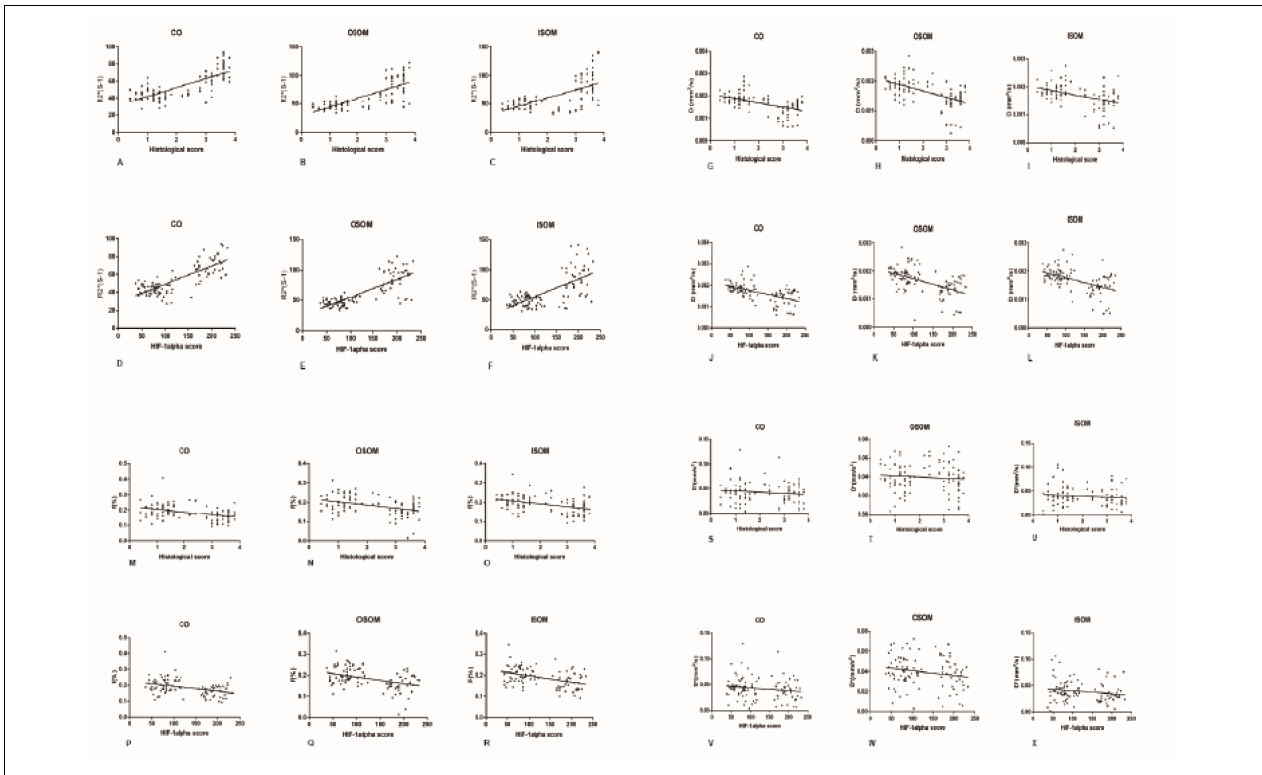
FIGURE 9 | Correlation between fMRI and pathology. (A-F) R 2 * vs histology and HIF-1 α : (A) r = 0.7605, (B) r = 0.7546, (C) r = 0.6331, (D) r = 0.7926, (E) r = 0.7824, and (F) r = 0.6952 ( P < 0.0001). (G-L) D vs histology and HIF-1 α : (G) r = − 0.515, (H) r = − 0.5356, (I) r = − 0.4498, (J) r = − 0.559, (K) r = − 0.5261, and (L) r = − 0.5123 ( P < 0.0001). (M-R) f vs histology and HIF-1 α : (M) r = − 0.3858, (N) r = − 0.4021, (O) r = − 0.3981, (P) r = − 0.3828, (Q) r = − 0.4144, and (R) r = − 0.4357 ( P < 0.0001). (S-X) D* vs histology and HIF-1 α : (S) r = 0.1171, (T) r = − 0.09212, (U) r = − 0.1064, (V) r = − 0.162, (W) r = − 0.1996, and